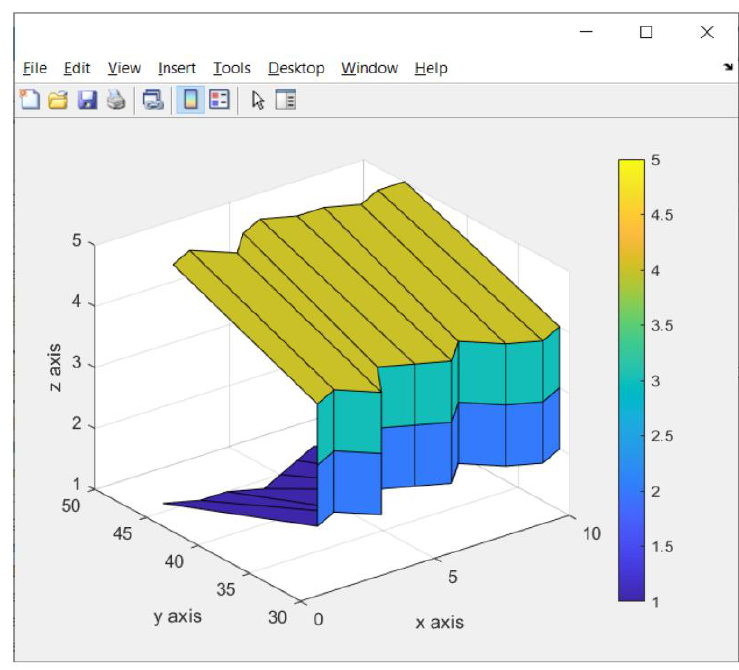
Figure 23. Result of fast scanning image of the trash object (box).